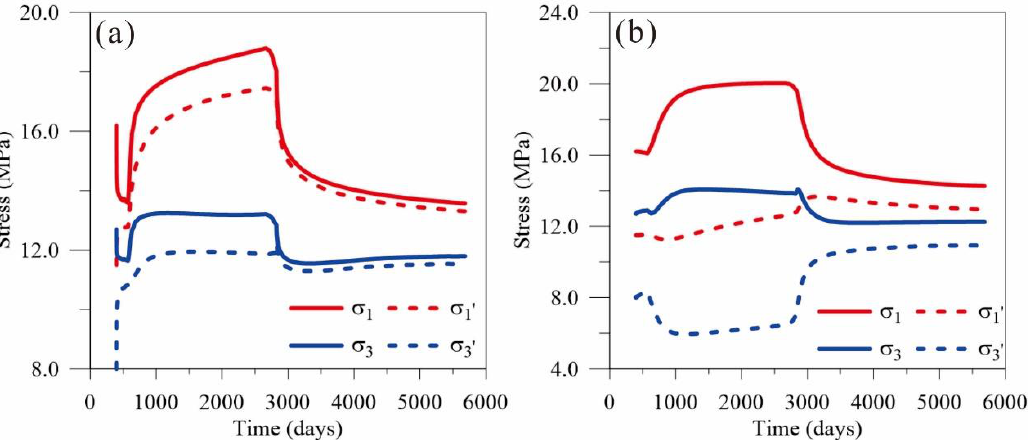
Figure 15. Temporal evolutions of the total stresses ( 𝜎 1 and 𝜎 3 ) and effective stresses ( 𝜎 1′ and 𝜎 3′ ) at ( a ) 1.0 m and ( b ) 5.0 m away from the ALC1604 cell along the bedding direction.